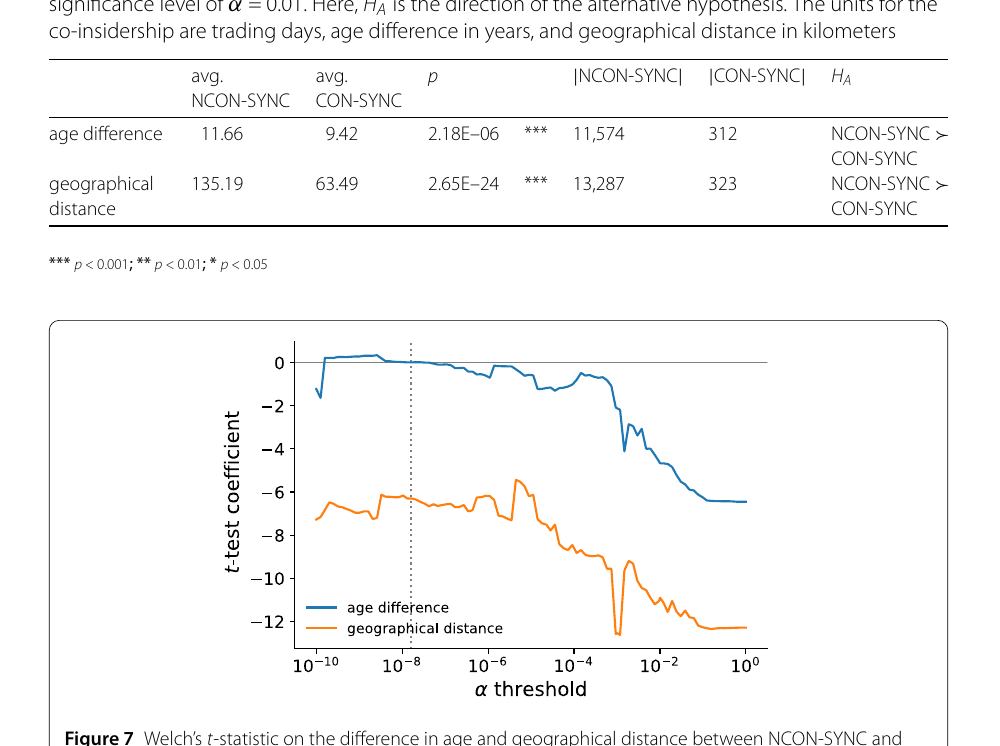
Figure 7 Welch’s t -statistic on the difference in age and geographical distance between NCON-SYNC and CON-SYNC sets. The statistic is reported for 100 log-spaced α thresholds used for the validation of investors’ trade synchronization. The dotted vertical line marks the Bonferroni validation